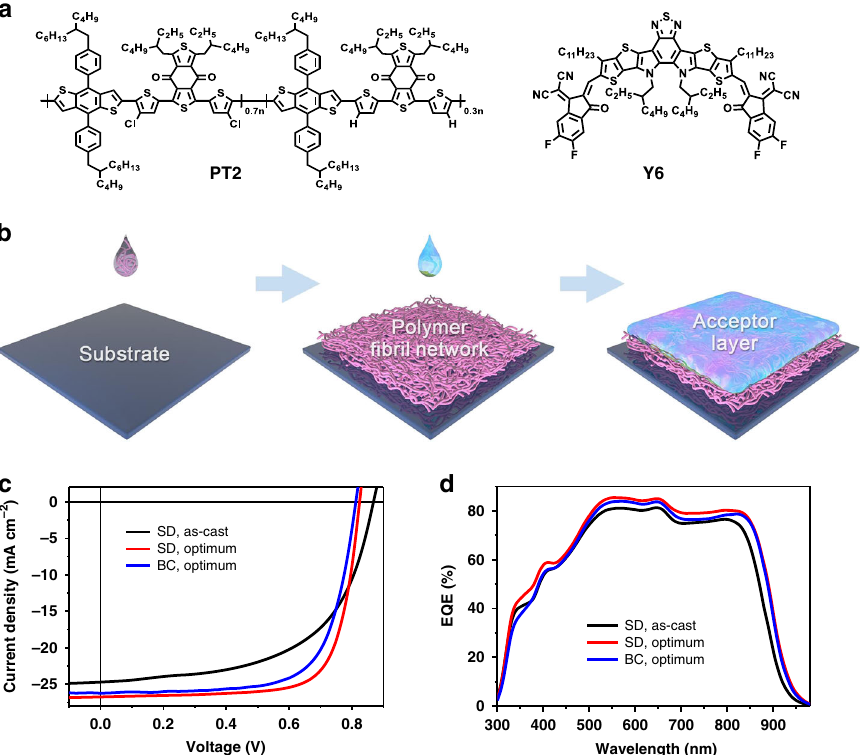
Fig. 1 Chemical structures, sequential deposition process, photovoltaic performance. a Chemical structures of PT2 and Y6. b Schematic illustration of fabrication procedure of SD blend fi lm. c J – V characteristics of SD and BC OSCs under constant incident light intensity (AM 1.5 G, 100 mW cm − 2 ), and d the corresponding EQE spectra. Table 1 Summary of device parameters of SD and BC OSCs.